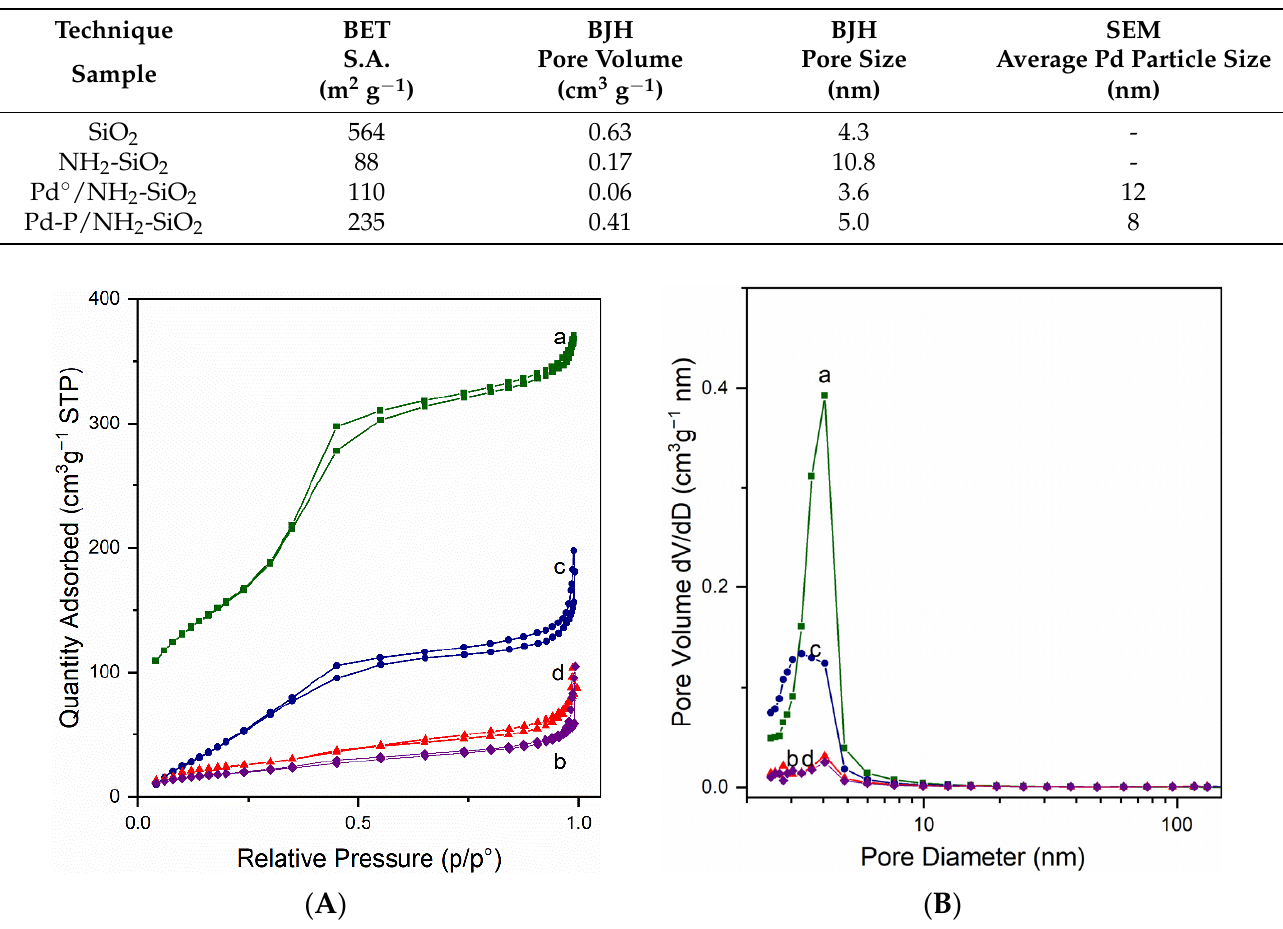
Figure 1. ( A ) N 2 adsorption and desorption isotherms, and ( B ) pore size distributions (PSD) of: (a) (a) SiO 2 , (b) NH 2 SiO 2 , (c) Pd-P /NH 2 -SiO 2 , (d) Pd ◦ /NH 2 -SiO 2 Table 1. Morphological properties of the samples by Brunauer–Emmett–Teller (BET) surface area (S.A.) analysis, Barrett–Joyner–Halenda (BJH) pore analysis and scanning electron microscopy (SEM).